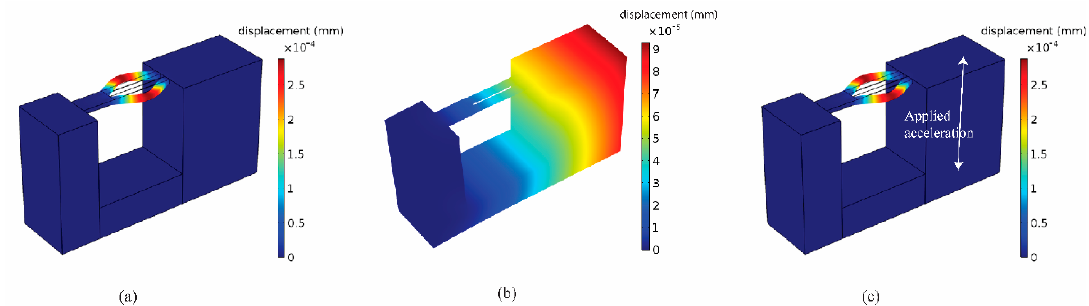
Figure 6. 3D topology of the final design of the DETF-based resonant accelerator.